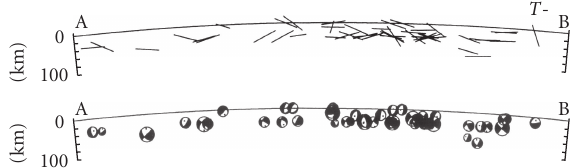
Figure 6: Projections of the vertical section along the line AB in a general E-W direction for the T-axes and equal area projection diagrams of focal mechanism solutions of events (1933–2003, M ≥ 4 . 5) in the region encircled by a dashed line in Figure 2.